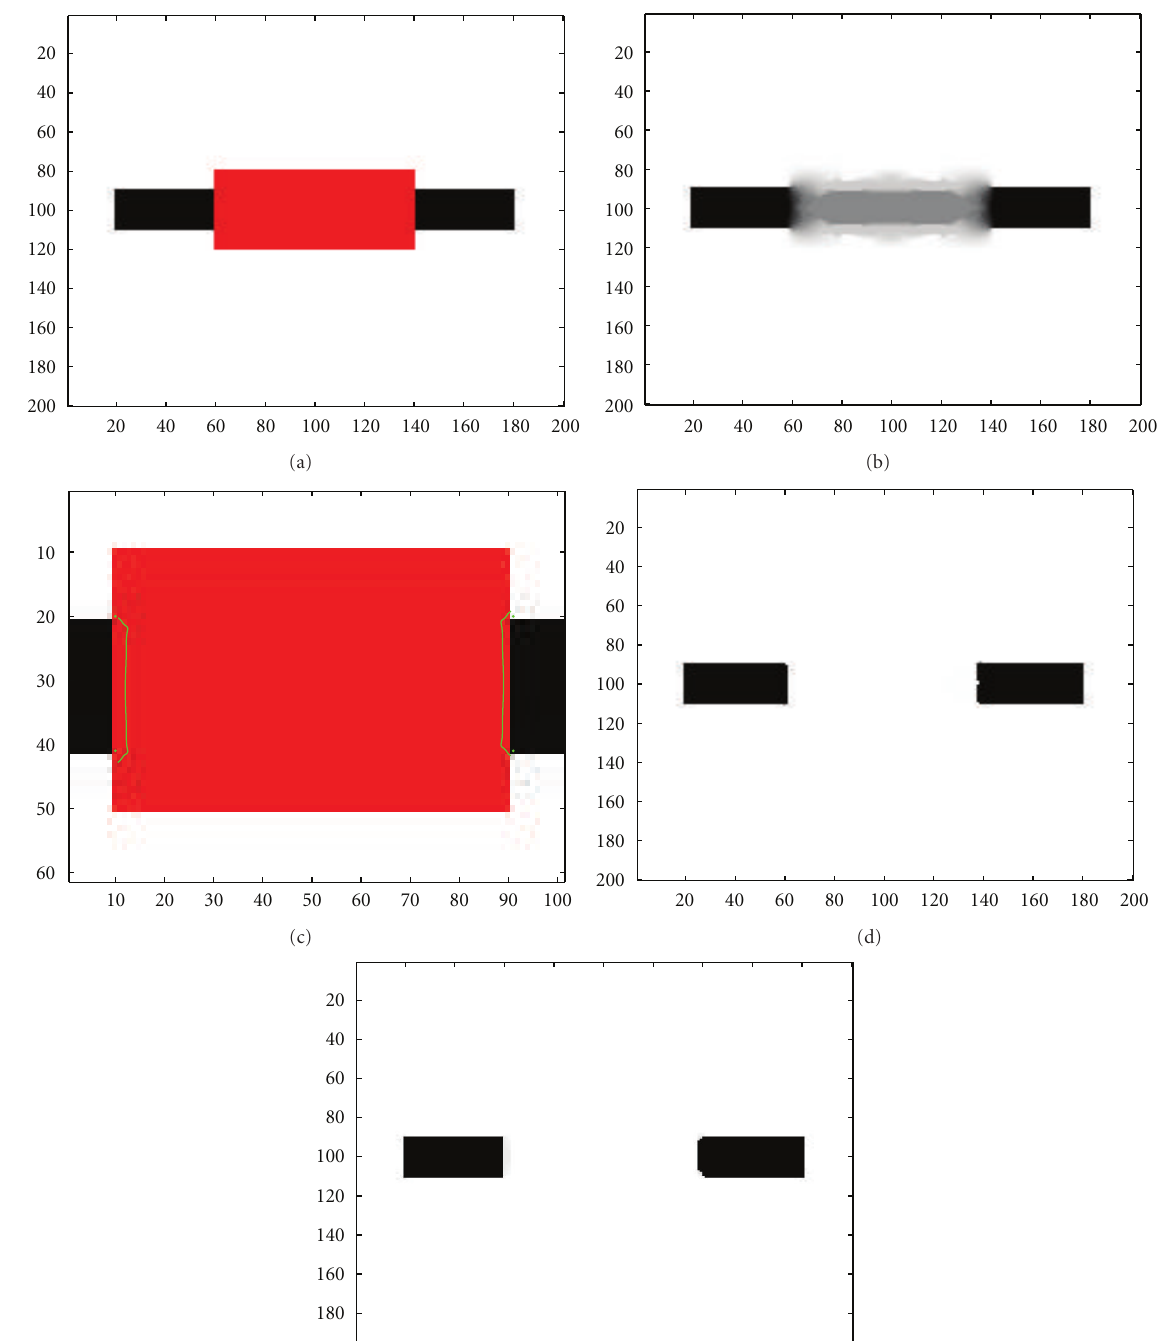
Figure 10: (a) Occluded image (black rectangle) by a red rectangle; (b) Inpainted image using the standard topological gradient; (c) Minimal path between the keypoints represented on the topological gradient; (d) Inpainted image using the hybrid scheme (fast marching algorithm for closing the contours identified by the topological gradient); (e) Inpainted image using a TV-based method. are represented by a large black point on the same